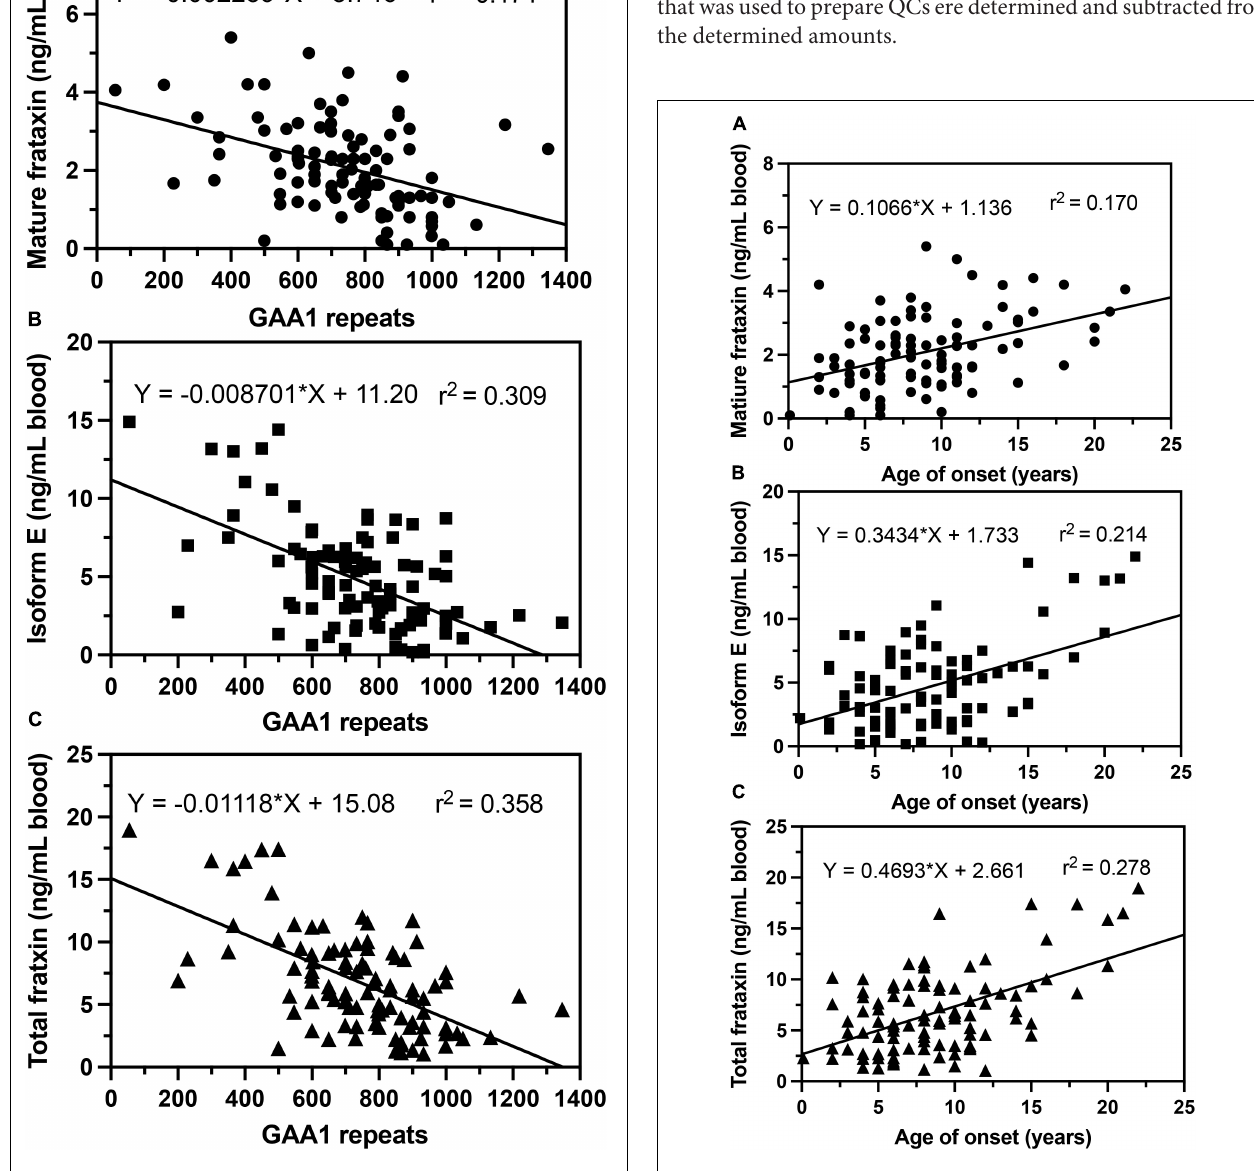
FIGURE 6 | Correlations of GAA repeat length on the shorter allele (GAA1) with whole blood frataxin levels. (A) Mature frataxin ( p < 0.0001). (B) Isoform E ( p < 0.0001). (C) Total frataxin ( p < 0.0001).